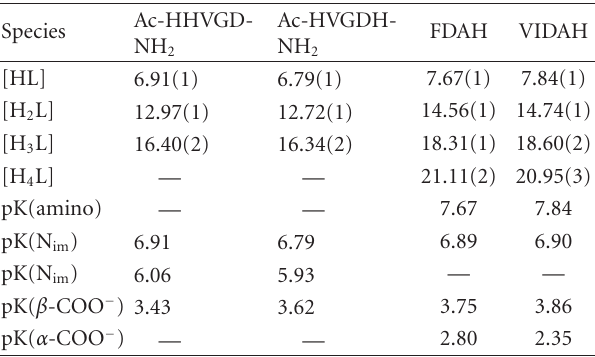
Table 1: Protonation macroconstants and stepwise pK values of the peptides T = 298K, I = 0.2 mol/dm 3 KCl (charges are omitted).